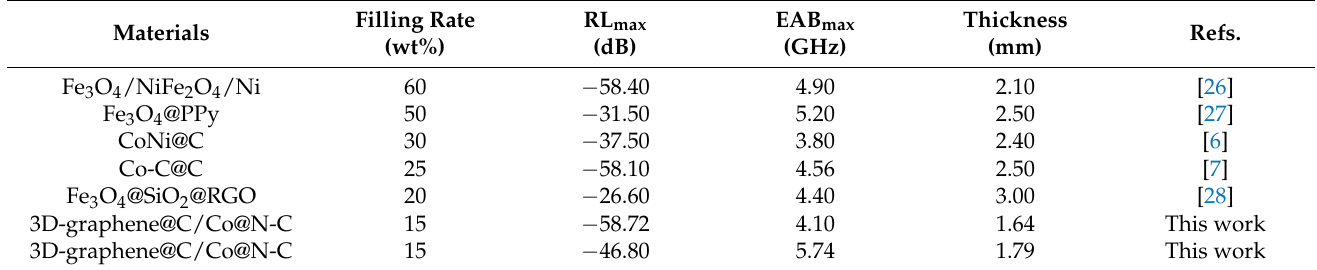
Table 1. Microwave absorption performances of other composites in the previous